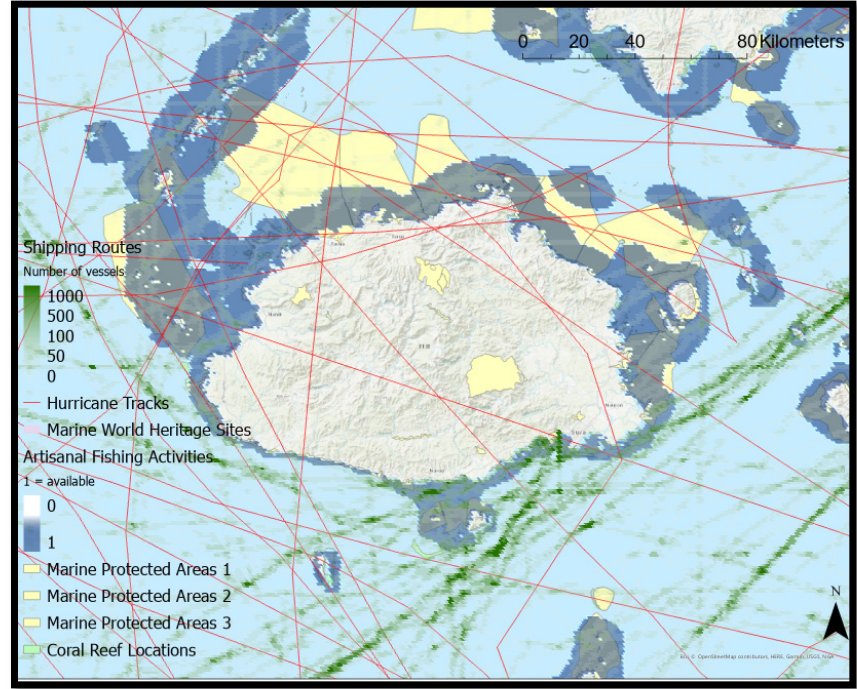
Figure 5. Map for Viti Levu demonstrating challenges found through spatial analysis. Color layers as per explained in Figure 4’s caption.